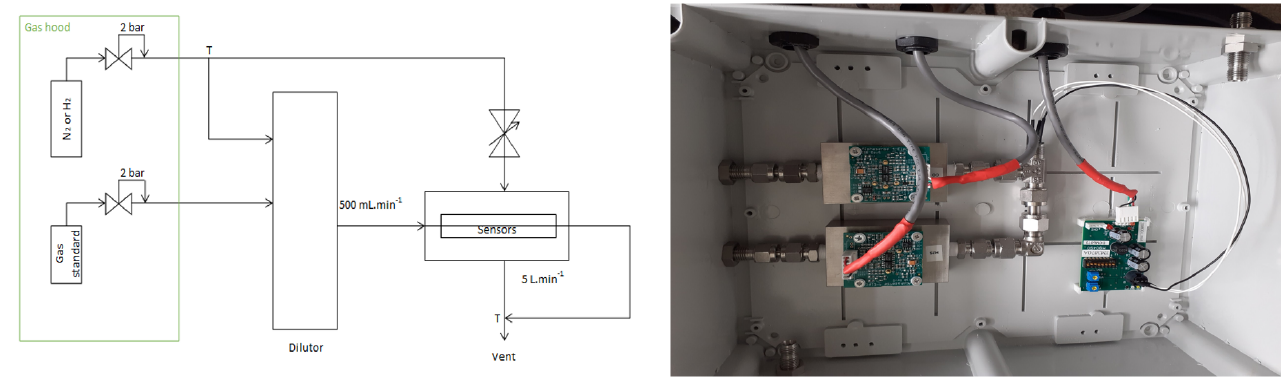
Figure 2. Diagram of the sensor testing setup and picture of the enclosure with sensor ready for